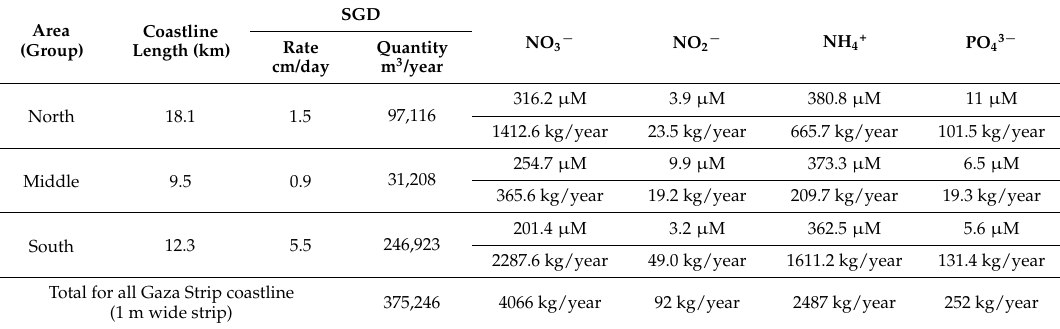
Table 5. SGD and associated nutrient discharge occurring in a 1 m wide strip along the Gaza